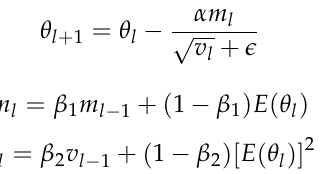
Figure 6. Accuracy and computation time at different mini-batch sizes. The accuracy and computation time at different maximum numbers of epochs are depicted in Figure 7, when the hidden layer size is set to 300 and the mini-batch size is set to 7. It can be shown that as the maximum number of epochs raises from 10 to 80, the accuracy curve has a distinct peak with the maximum number of epochs set to 50 while the computation time curve always rises as the layer size get bigger. By considering com- prehensively from both facets of accuracy and computation time, the maximum number of epochs is selected as 50.